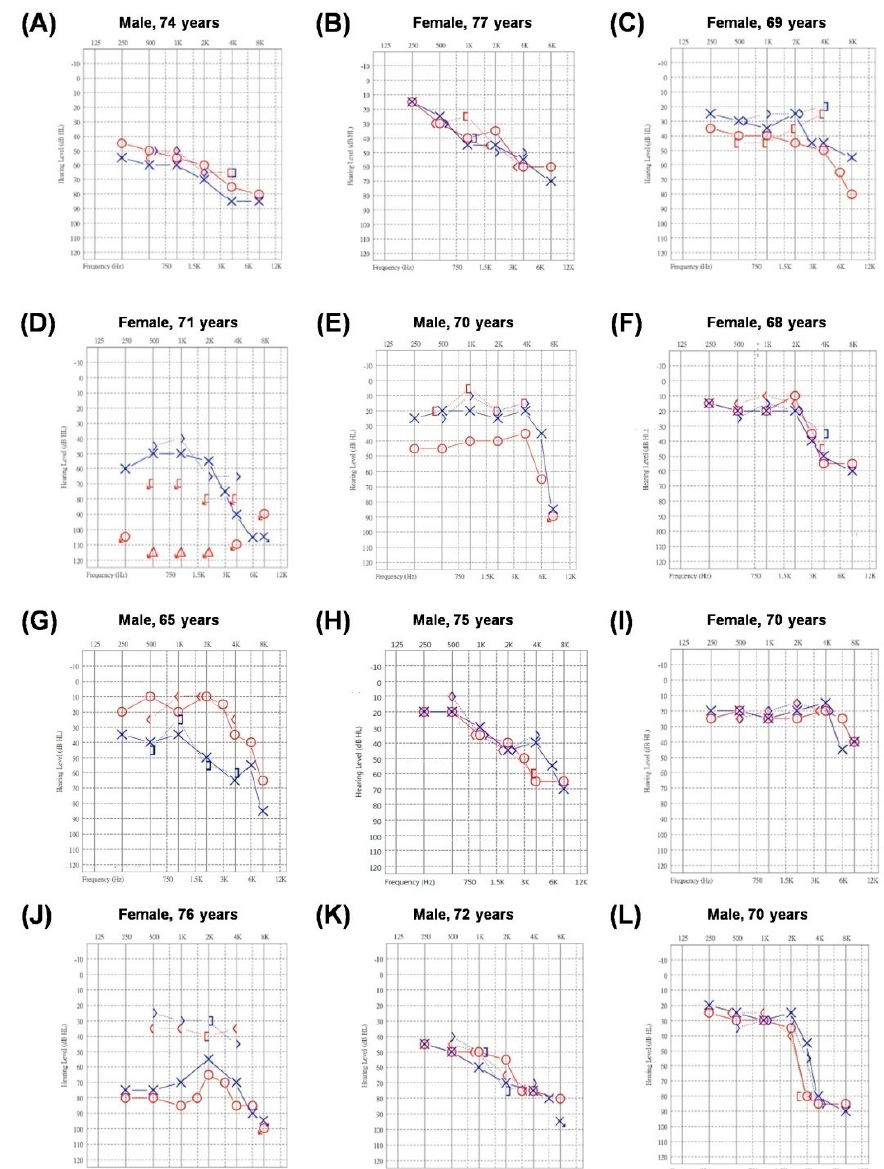
Figure 1. ( A – L ) Age, sex, and audiograms of twelve patients with the KCNQ4 c.546C>G variant. Right ear air conductions displayed as circles connected by lines, and left ear air conductions are represented denoted by × ’s connected by lines.